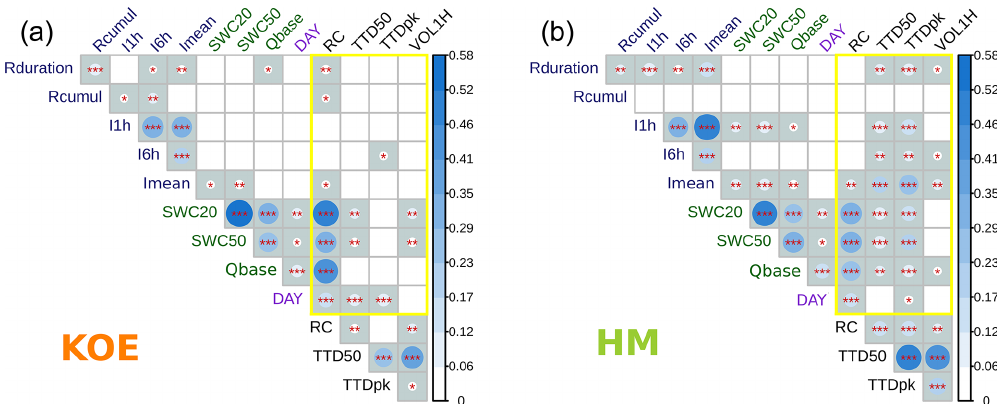
Figure 12. Hoeffding correlation coefficients between rainfall (blue), catchment hydrological states (green), seasonal cycle (DAY of the year), and outlet runoff properties (black). See Sect. 3.2 for more details on properties. The left and the right panels refer to KOE and HM catchment section, respectively. The size and the color of the circles are related to the Hoeffding coefficients. The yellow box highlights the scores of interest for our study. The blue background and the red stars indicate the significant correlations: ∗∗∗ when p -value < 10 − 3 ; ∗∗ when 10 − 3 <p -value < 10 − 2 ; ∗ when 10 − 2 <p -value < 2 × 10 − 2